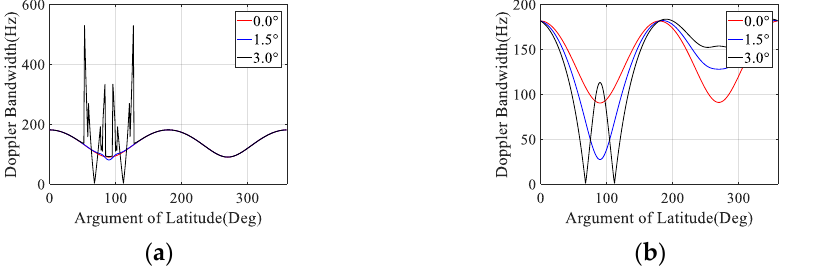
Figure 8. Doppler bandwidth along the orbit. ( a ) With the consideration of variations of the RLS; ( b ) without the consideration of variations of the RLS.